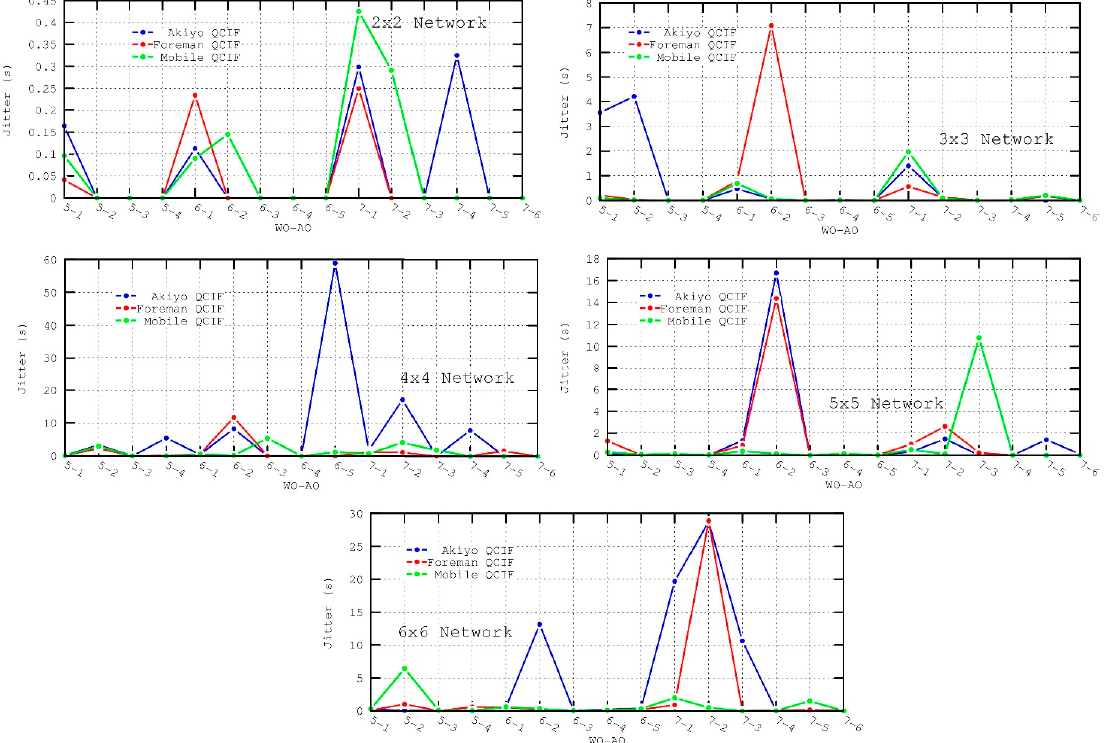
Figure 11. Jitter metric for the different scenarios.